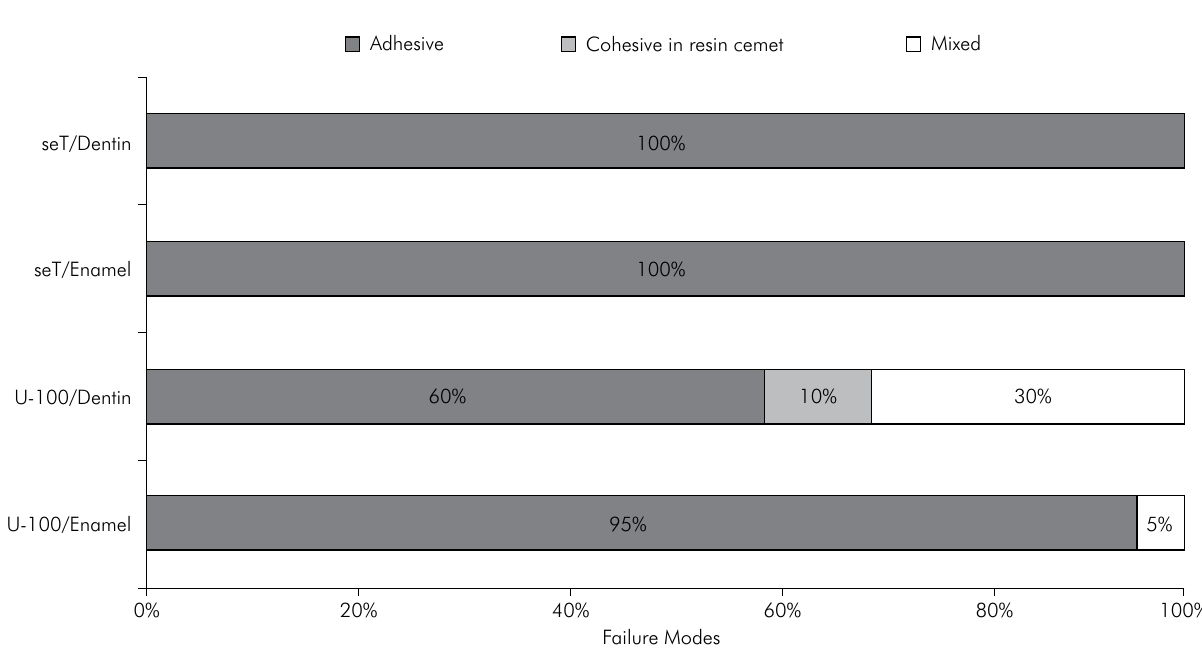
Figure 1. Incidence of failure modes (%) of self-adhesive resin cements, RelyX U-100 and seT PP to dentin and enamel, analyzed by